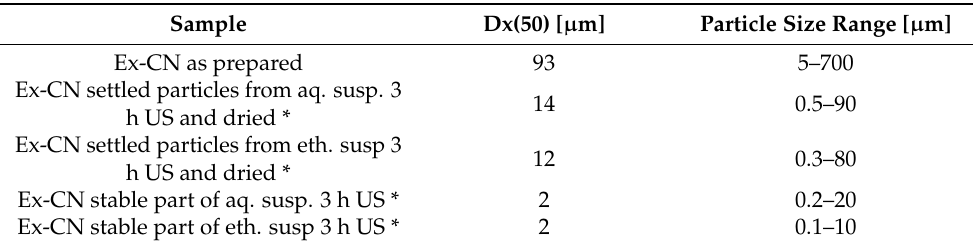
Table 1. The influence of ultrasonic treatment on the hydrodynamic particle size of exfoliated g-C 3 N 4